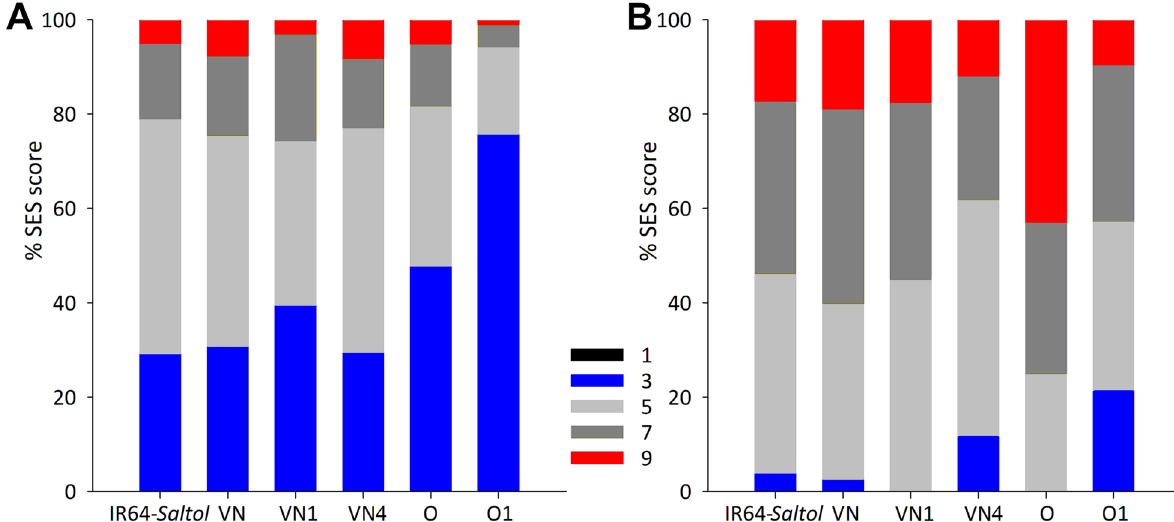
Fig. 5 SES evaluation of the parental IR64- Saltol , the tolerant check, Vialone Nano (VN) and Onice (O), the susceptible checks and VN1, VN4, O1 introgression lines, after 7 days ( A ) and 14 days ( B ) of exposure to 80 mM NaCl. Data, expressed as the percentage of plants at each score value (1, highly tolerant; 3, tolerant; 5, moderately tolerant; 7, sensitive; 9, highly sensitive), are the means obtained from three independent experiments (12 plants/genotype each